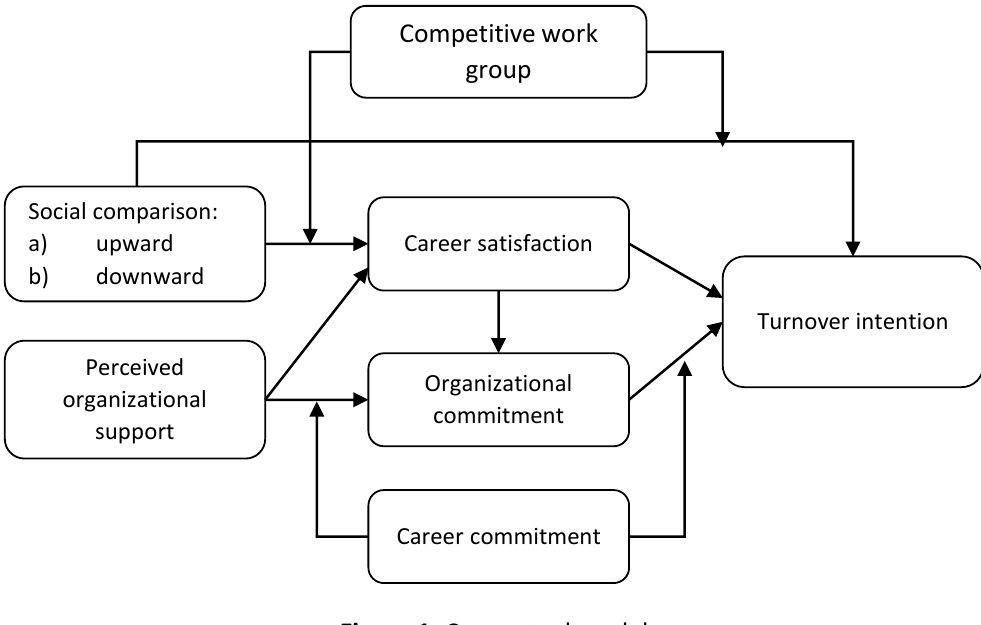
Figure 1. Conceptual